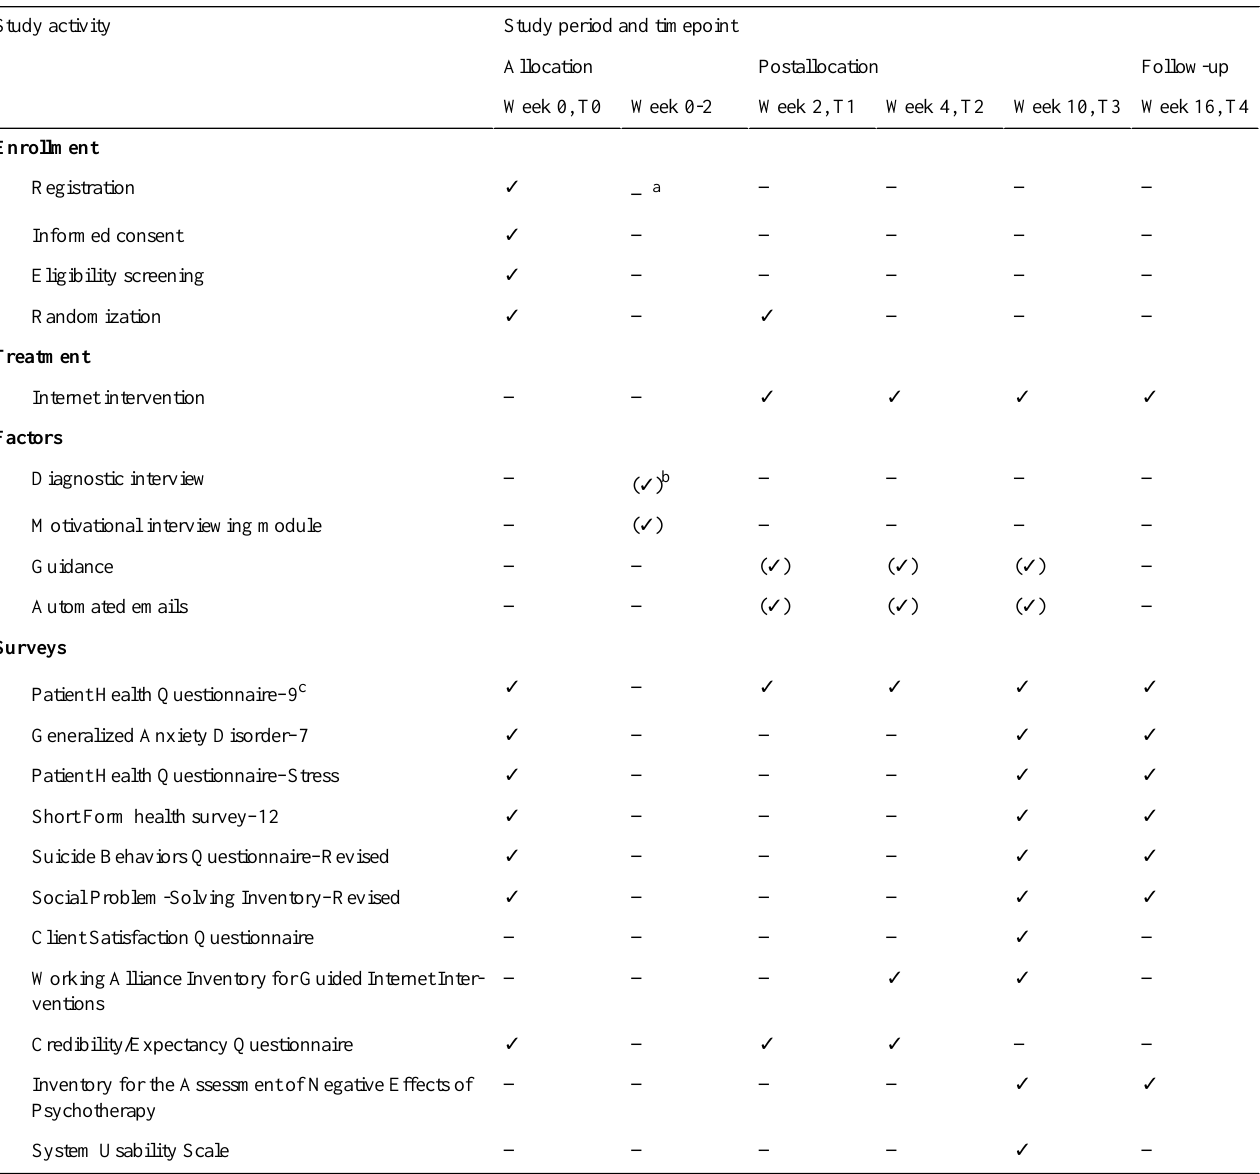
Table 2. Study flow and overview of study